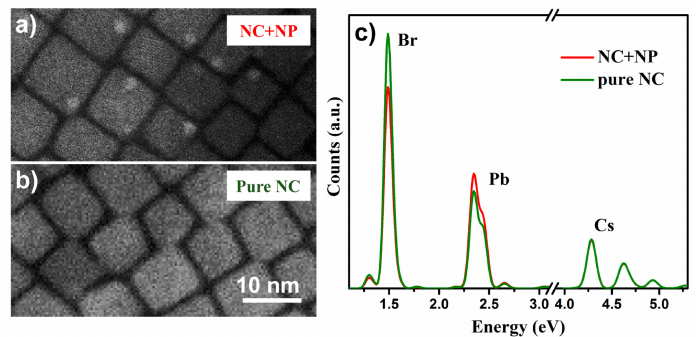
Figure 5. HAADF images of the NC+NP ( a ) and pure NC ( b ) regions. ( c ) Integrated EDS spectra acquired from NC+NP (—) and pure NC (—) regions as shown in ( a ) and ( b ), respectively.